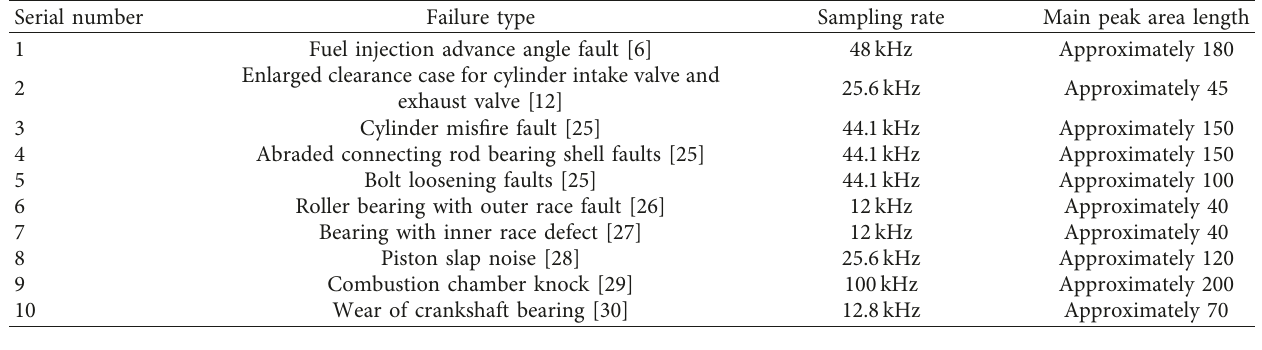
Table 1: Length of the main energy areas of engine fault components and mechanical faults found in other studies.